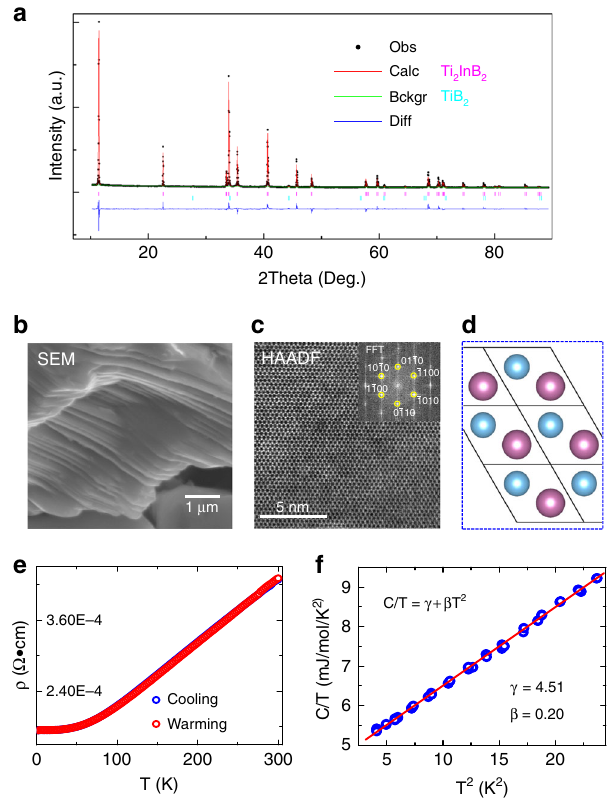
Fig. 3 Experimental characterization of synthesized Ti 2 InB 2 compound after HCl etching. a Powder XRD pattern with Rietveld analysis using GSAS package 42 . A small amount of TiB 2 is evident. b SEM image of a particle showing a laminated structure. c HAADF-STEM image from the [001] direction. The inset shows the corresponding FFT pattern. d Crystal structure viewed from the z -direction (blue and purple spheres respectively indicate Ti and In atoms). Boron is not shown and the black lines represent the unit cells. e Electrical resistivity. f Heat capacity plotted as C/T vs. T 2 at low temperature. The red line represents a linear fi t to the